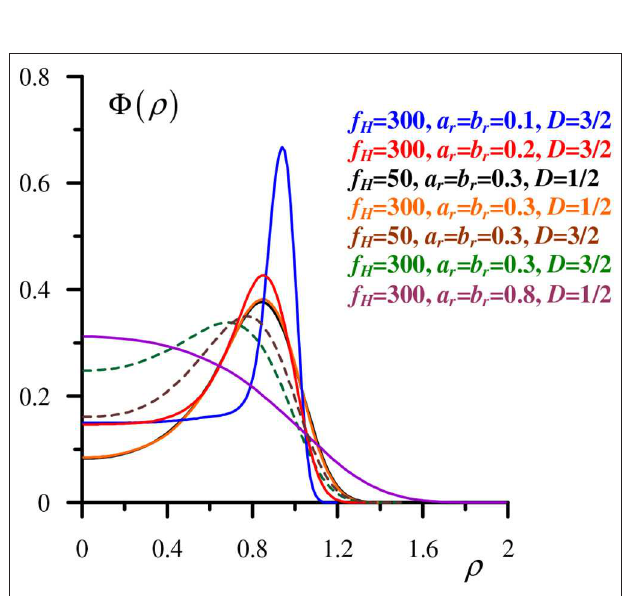
FIGURE 6 | Normalized form-factor of the surface density of the dissipated energy for different values of